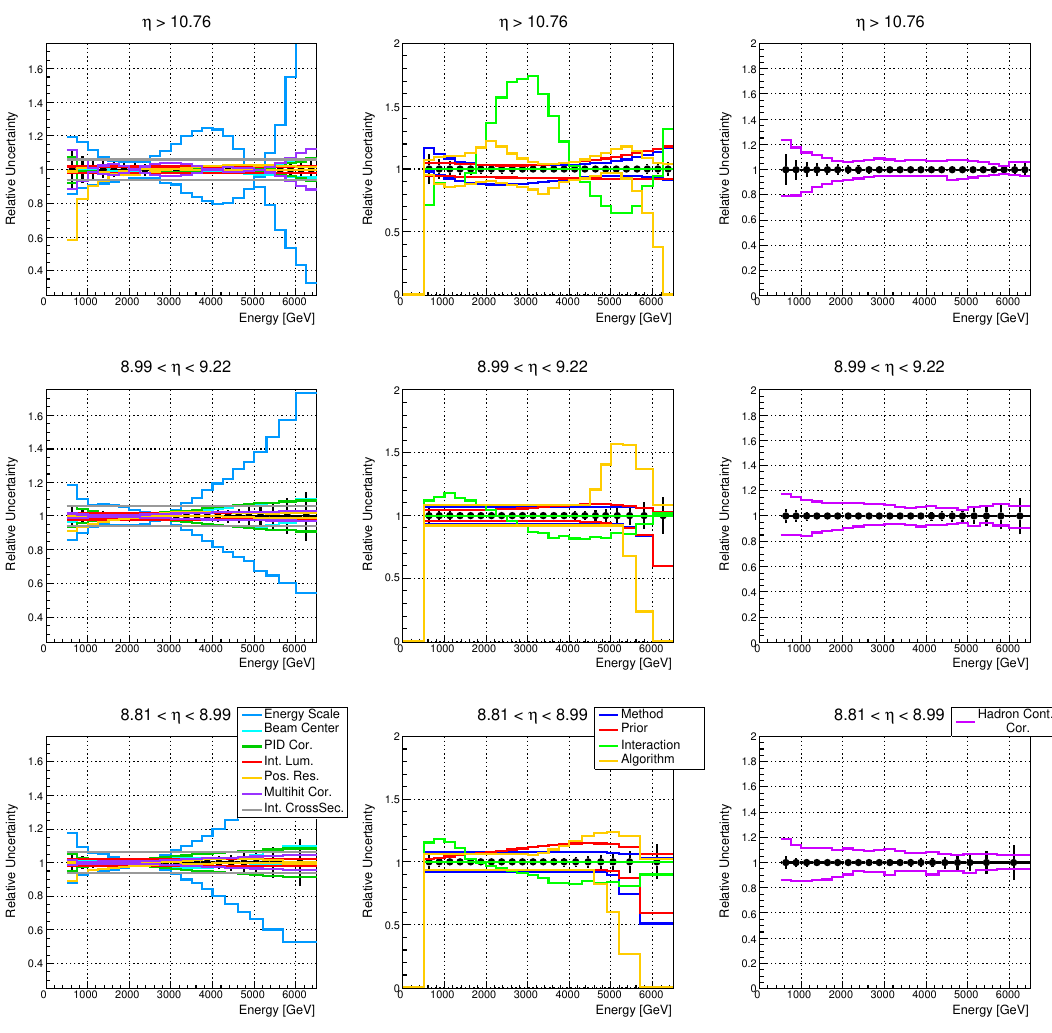
Figure 4 . Relative systematic uncertainties for the (cid:12)nal unfolded distributions. From left to right, the three columns represent: the uncertainties already associated to the folded spectra, the uncertainties due to the unfolding procedure and the uncertainties related to hadron contamination corrections. Black markers show the statistical error present on the unfolded